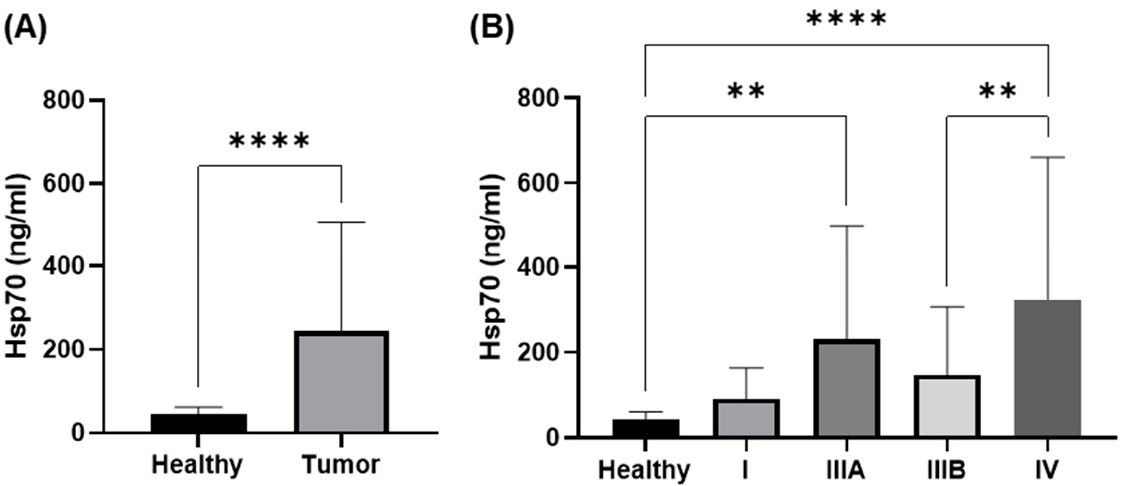
Figure 2. Measurement of exosomal and free Hsp70 in the peripheral blood of healthy volunteers vs. NSCLC patients as determined by the compHsp70 ELISA. The Hsp70 levels were compared in healthy controls ( n = 42) vs. NSCLC patients in different UICC stages ( n = 113) ( A ) and in healthy controls ( n = 42) vs. NSCLC patients in UICC stages I ( n = 6), IIIA ( n = 32), IIIB ( n = 33), and IV ( n = 42) ( B ). Statistically significant differences were ** p < 0.01 and **** p < 0.0001.